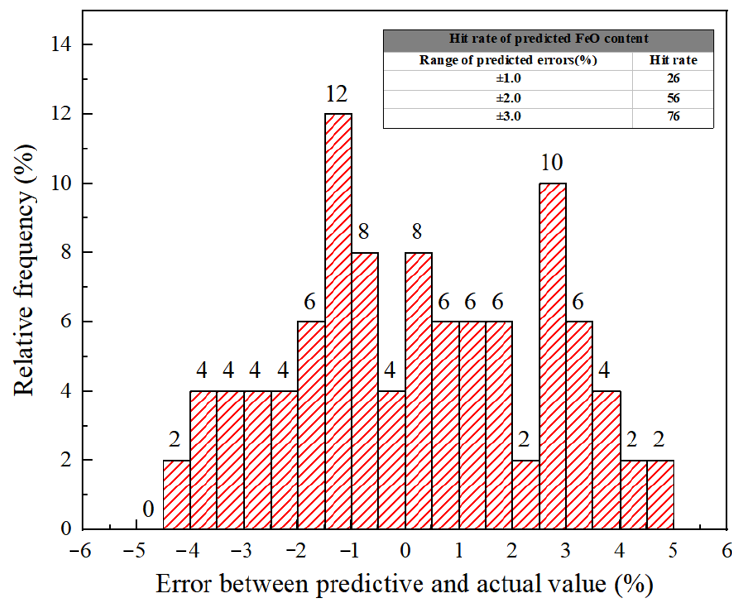
Figure 4. Error distribution of MLR predicted model.